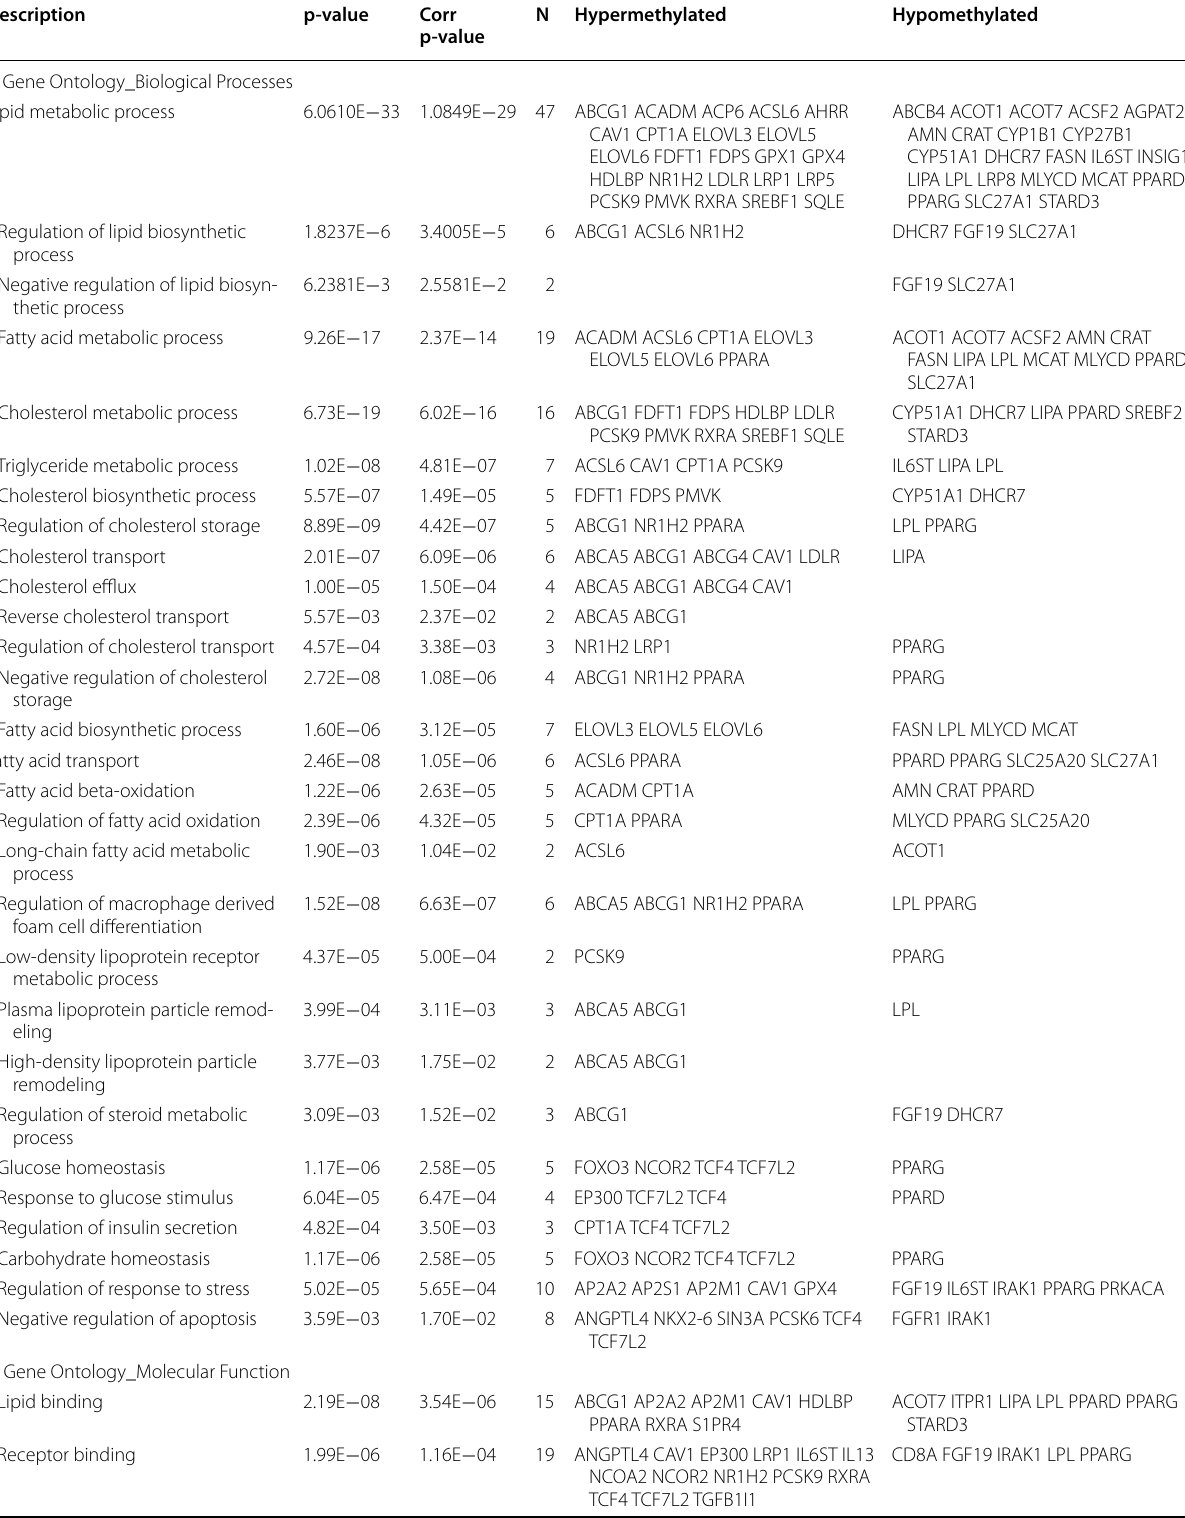
Table 3 Results of statistically overrepresented biological processes and molecular function in set of differentially methylated